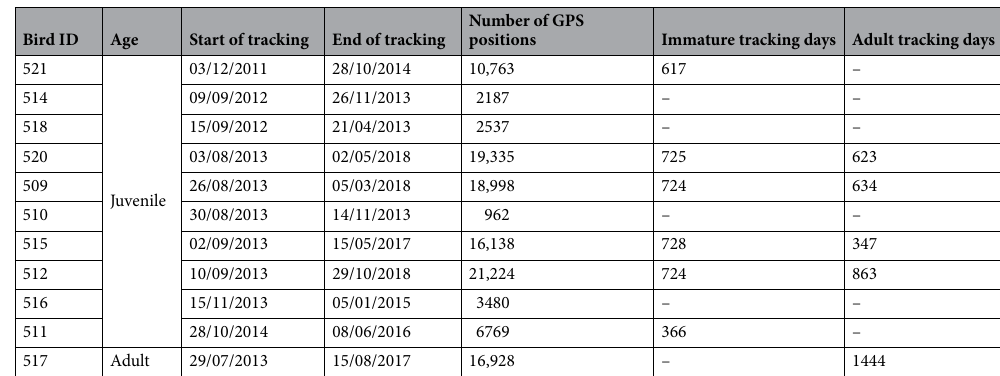
Table 1. Information for the tracked Shoebills: age of the individual at the time of logger deployment, start and end dates of tracking, total number of valid GPS positions, excluding outliers, and total number of tracking days as immature and